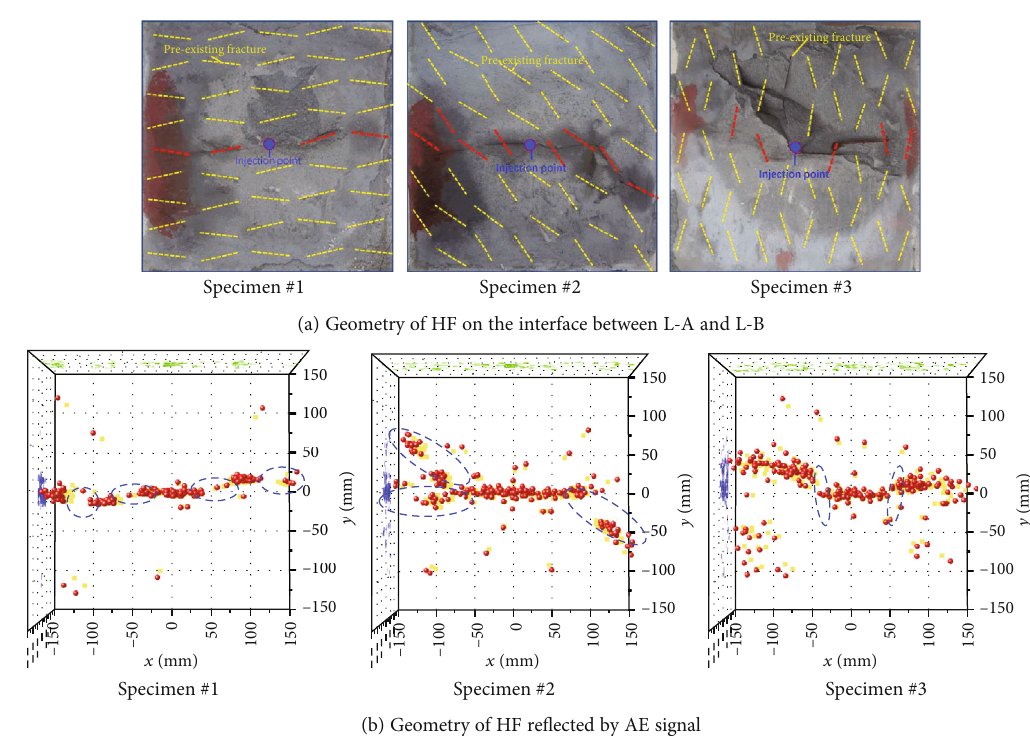
The characteristics of the stage (I), (II), and (IV) of three specimens are similar, but stage (III) has di ff erent changes. At the stage (III) of specimen #1, the injection pressure